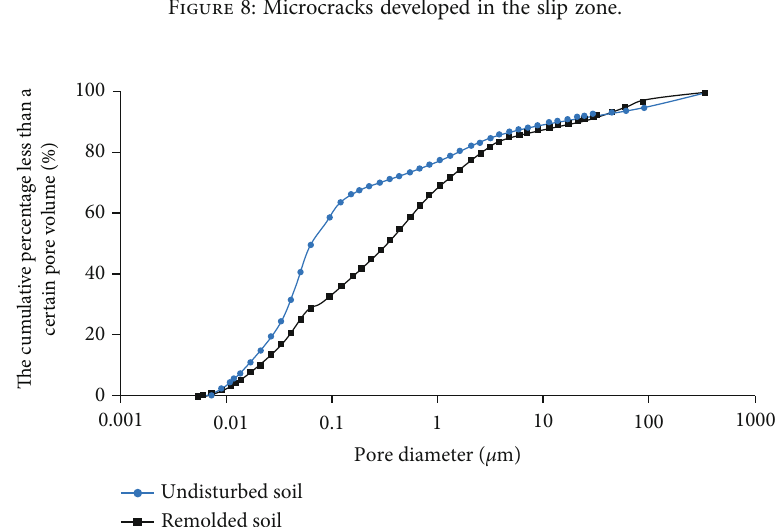
Figure 8: Microcracks developed in the slip